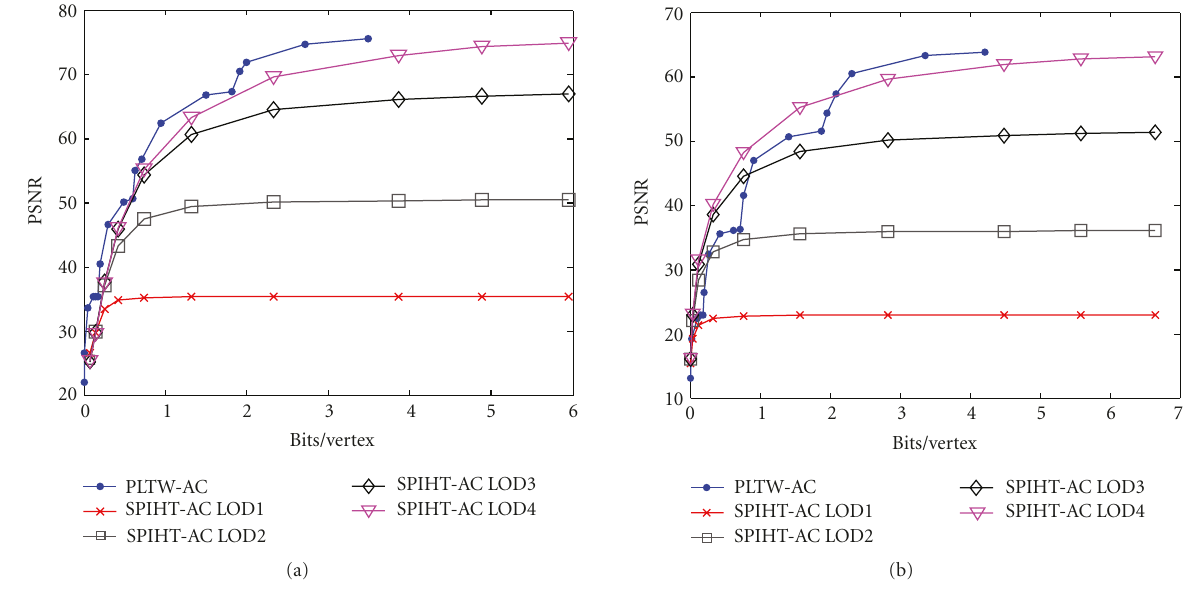
Figure 2: PLTW versus SPIHT for the Max Planck (a) and bunny (b) models.